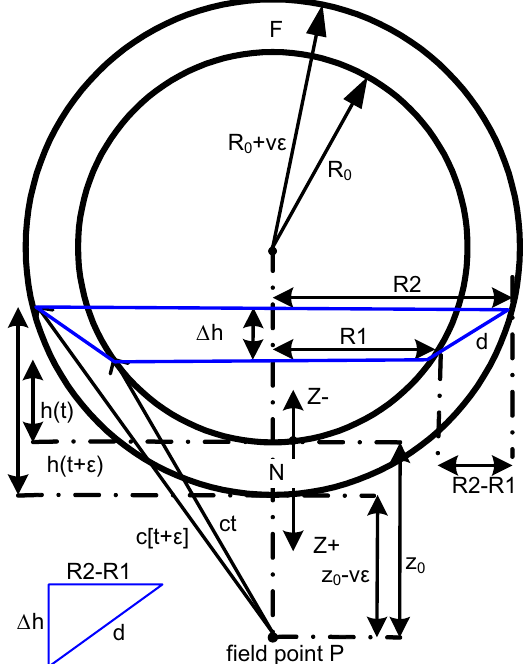
Figure 7. The impulsive spherical shell source (the ’sphere’) with initial radius R 0 expanding with a positive relative radial speed v where as with the planar source, v will be positive for forward wave fronts (in the direction of the expansion) and will be proceeded by a negative sign for backward wave fronts. R 1 is the radius of the circle created by the intersection at time t of a sphere centered at P of radius ct with the spherical source. R 2 is the radius of the circle created by the intersection at time t + ε of a sphere centered at P of radius c [ t + ε ] with the spherical